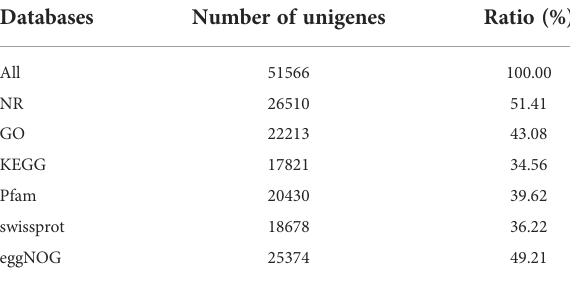
TABLE 4 Annotated number and ratio of the unigenes in various databases. Databases